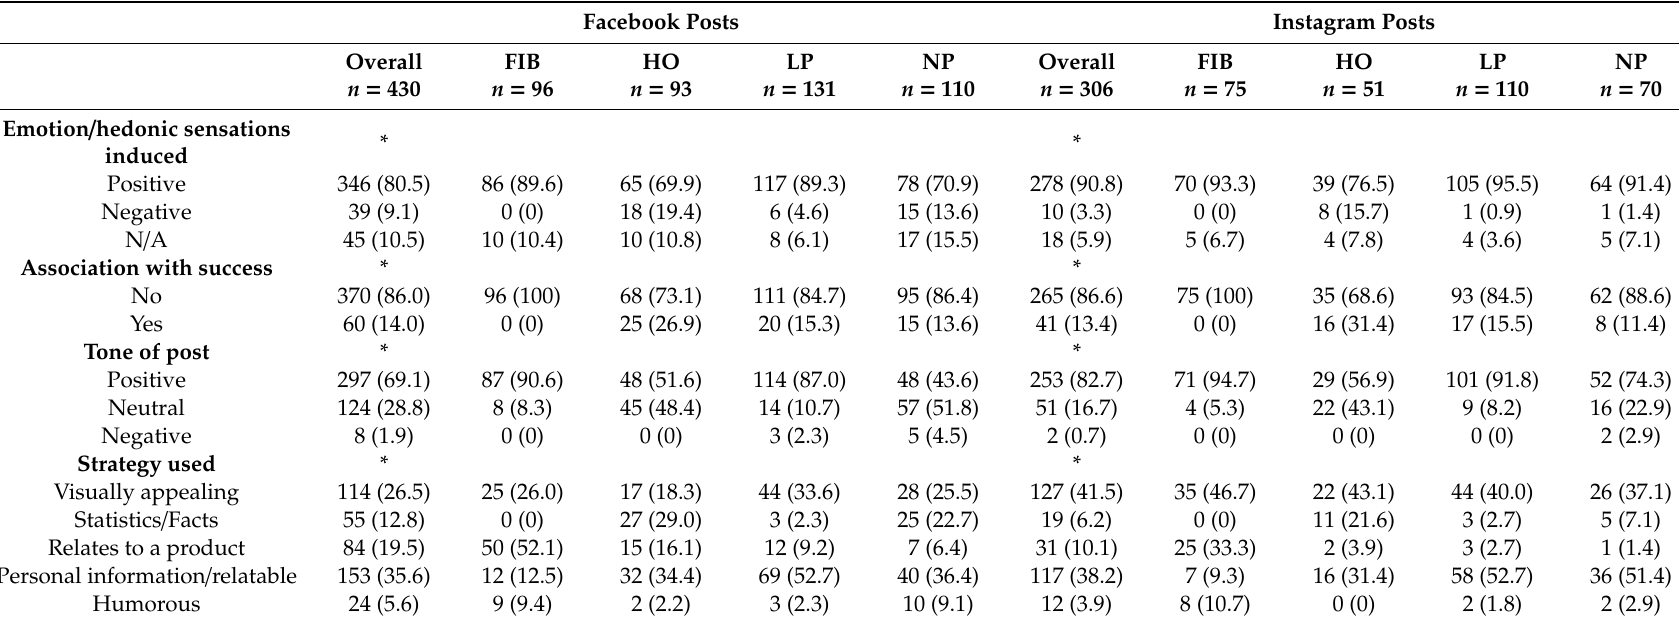
Table A3. Frequency of subjective social media strategies used by the fields across Facebook and